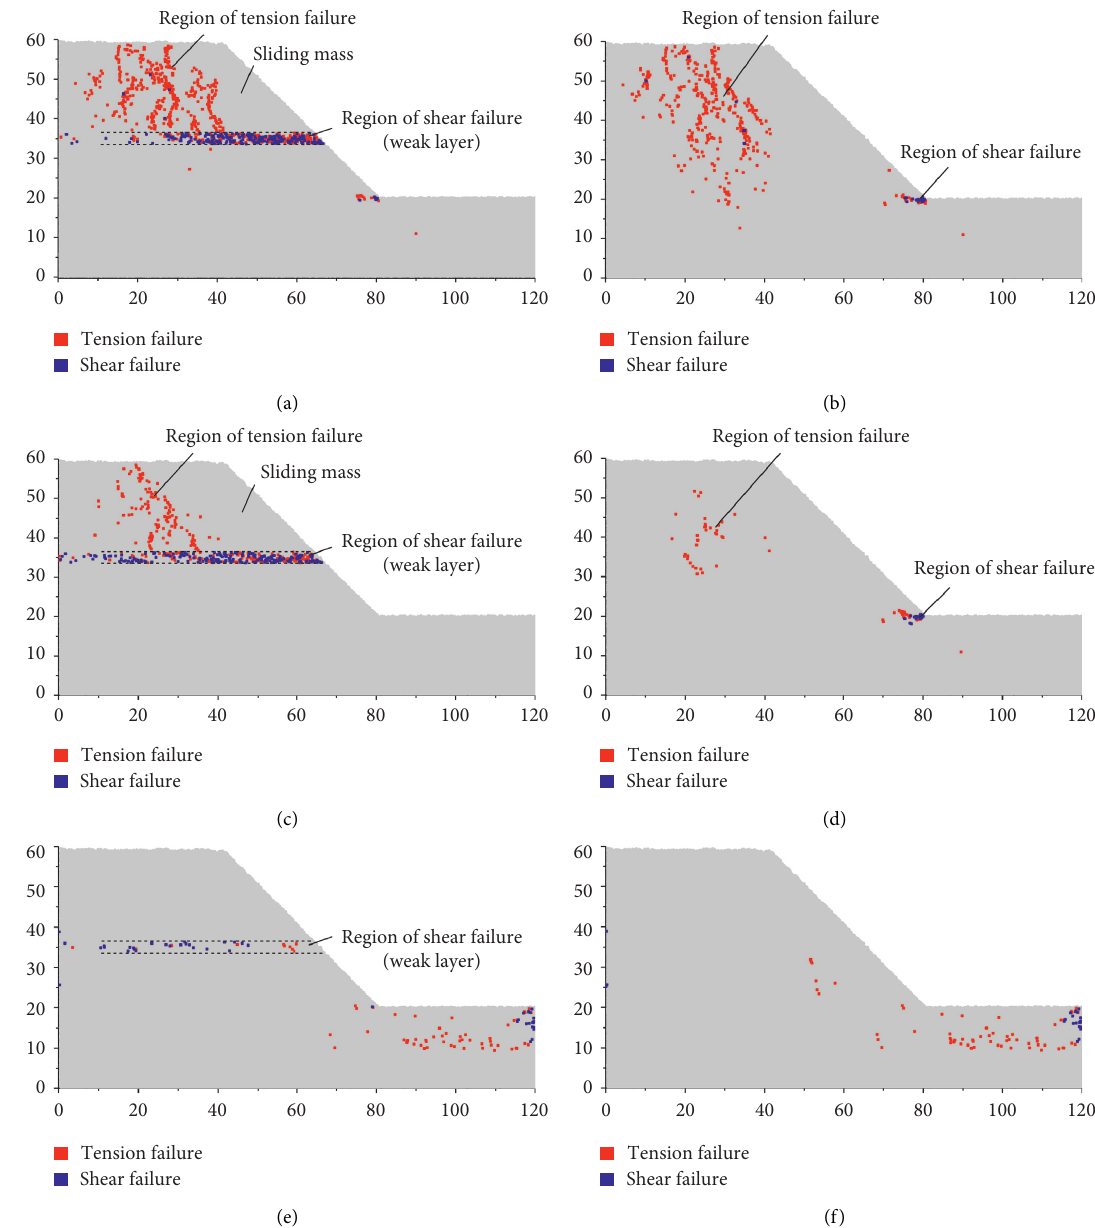
Figure 21: Spatial distribution of failure points inside slopes under different ground motions. (a) Slope with a weak interlayer under fling step ground motion. (b) Homogeneous slope under fling step ground motion. (c) Slope with a weak interlayer under directivity pulse ground motion. (d) Homogeneous slope under directivity pulse ground motion. (e) Slope with a weak interlayer under pulseless ground motion. (f) Homogeneous slope under pulseless ground